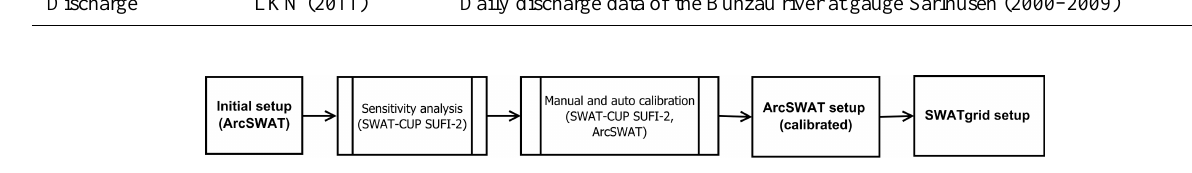
Fig. 3. Grid-based model calibration in chronological